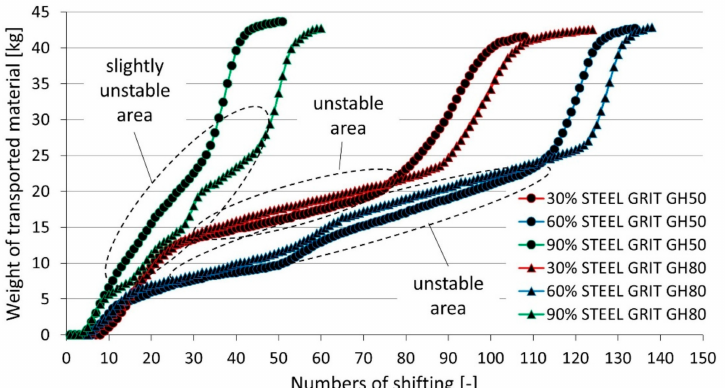
Figure 11. Dependence of real weight of the transported materials, STEEL GRIT GH50 and GH80, on number of the strokes during gradual feeding with 45 kg of this material at the 30%, 60% and 90% levels of the shifting speed.